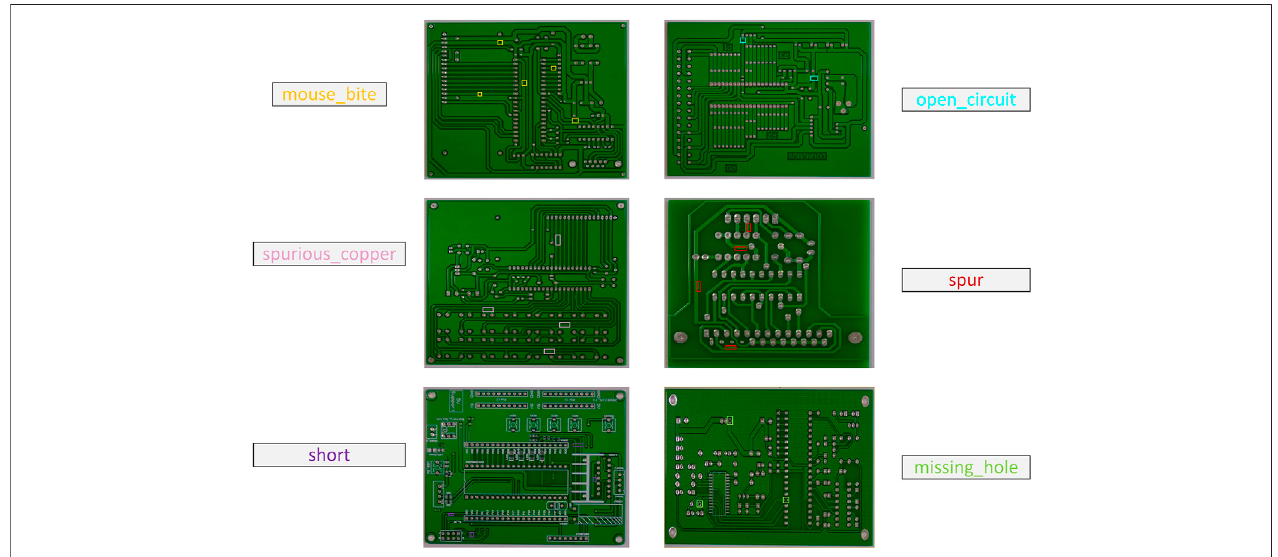
FIGURE 7 | Common defect types of PCB to be